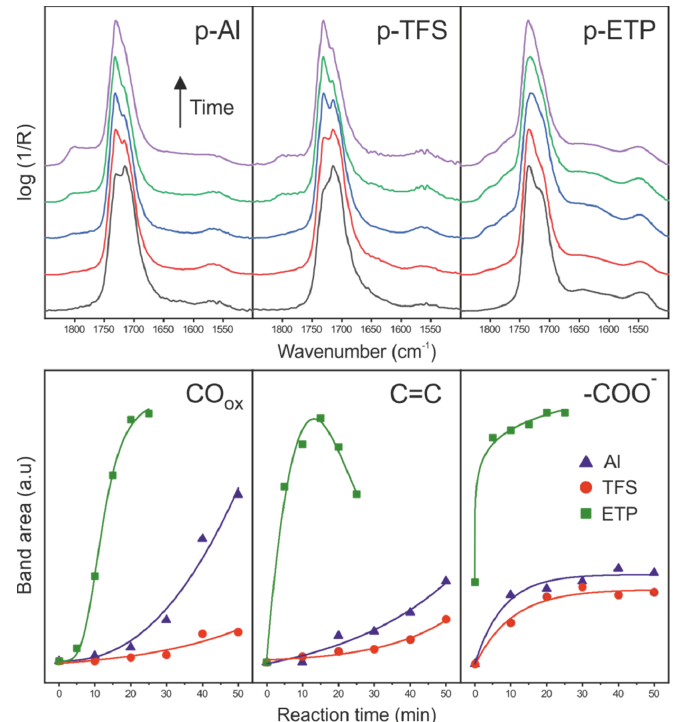
Figure 7. (top) ATR-FTIR spectra along the formation of polyaleuritate films on Al, TFS and ETP at 200 ◦ C in air (10–50 min for Al and TFS, 5–25 min for ETP). ( bottom ) Time evolution of CO ox , C = C and 200 °C in air (10–50 min for Al and TFS, 5–25 min for ETP). (bottom) Time evolution of CO ox , C=C and –COO − species from specular reflectance FTIR –COO − species from specular reflectance FTIR spectra.